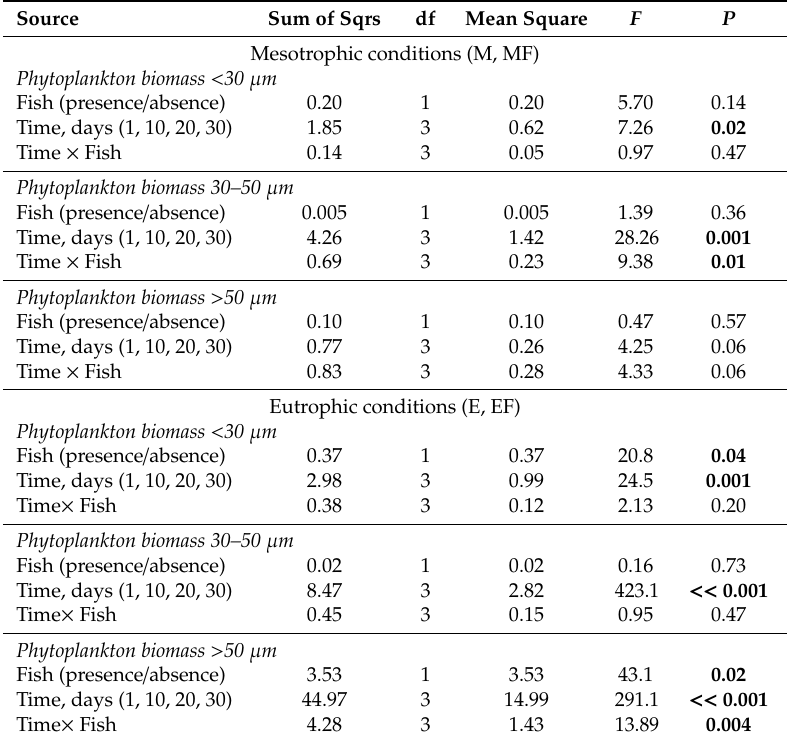
Table 4. Results of two-way repeated measures ANOVA (RM ANOVA) with factors treatment (M, MF, E, EF) and time. M—mesotrophic conditions, MF—mesotrophic conditions with introduced fish, E—eutrophic conditions, EF—eutrophic conditions with introduced fish. Significant results (p < 0.05) are shown in bold.